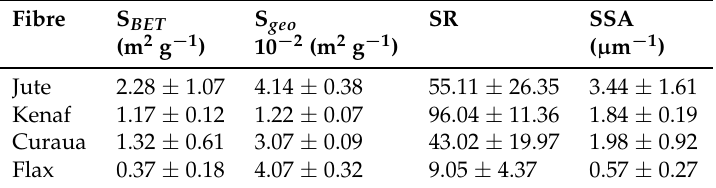
Table 2. Surface area properties of jute, kenaf, curaua, and flax fibres. S BET , S geo , SR, and SSA denote BET surface area, geometric surface area, surface roughness, and specific surface area,